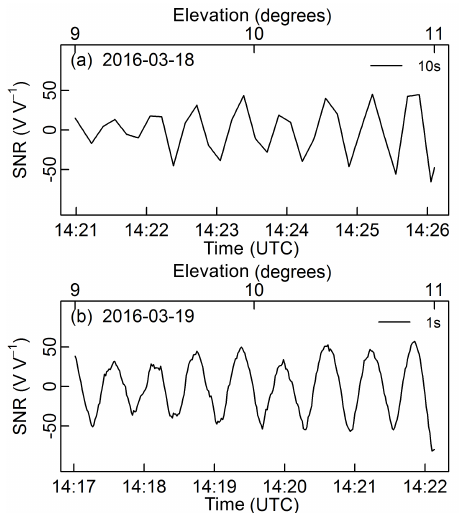
Figure 11. Two examples of L2C SNR data sets (from the GPS PRN 25 ascending tracks) acquired by the 29.4m antenna at two contiguous dates: (a) 18 March 2016 (with 10s sampling interval) and (b) 19 March 2016 (with 1s sampling